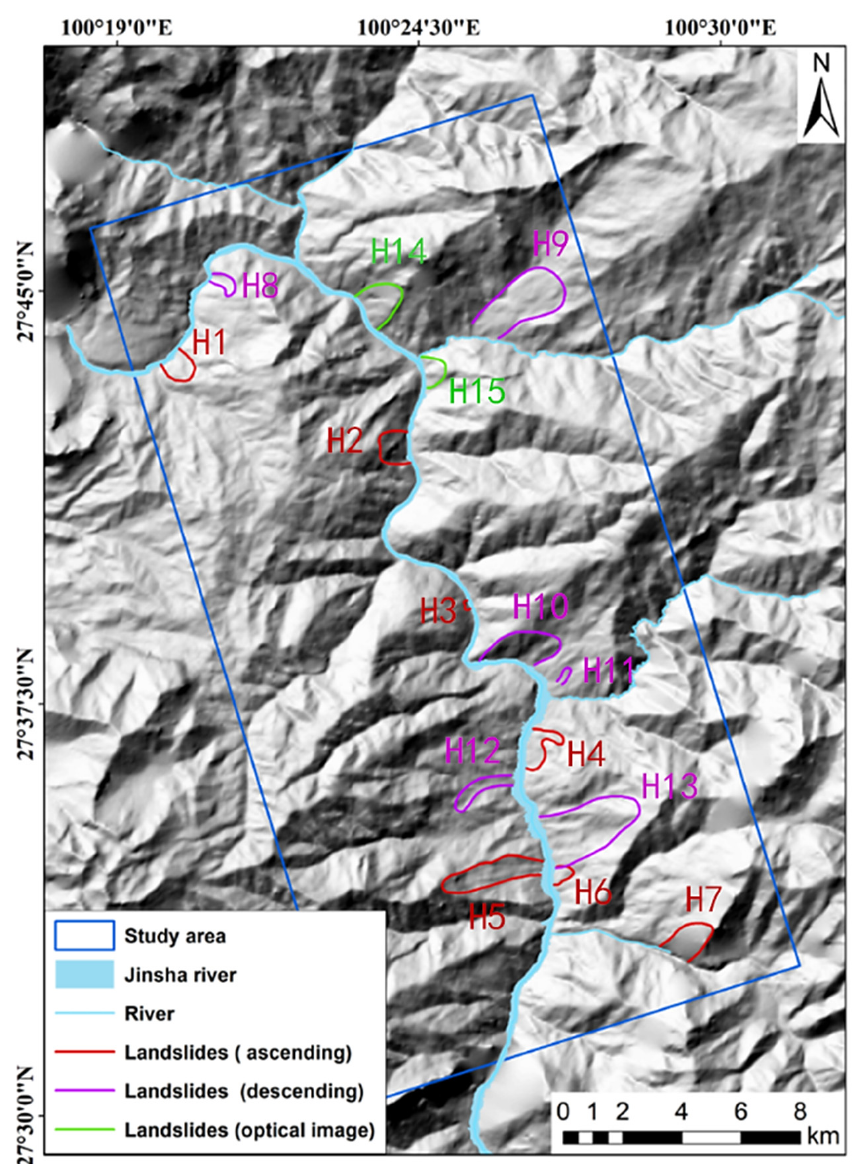
Figure 10. Sources of landslide identification results within the study area.